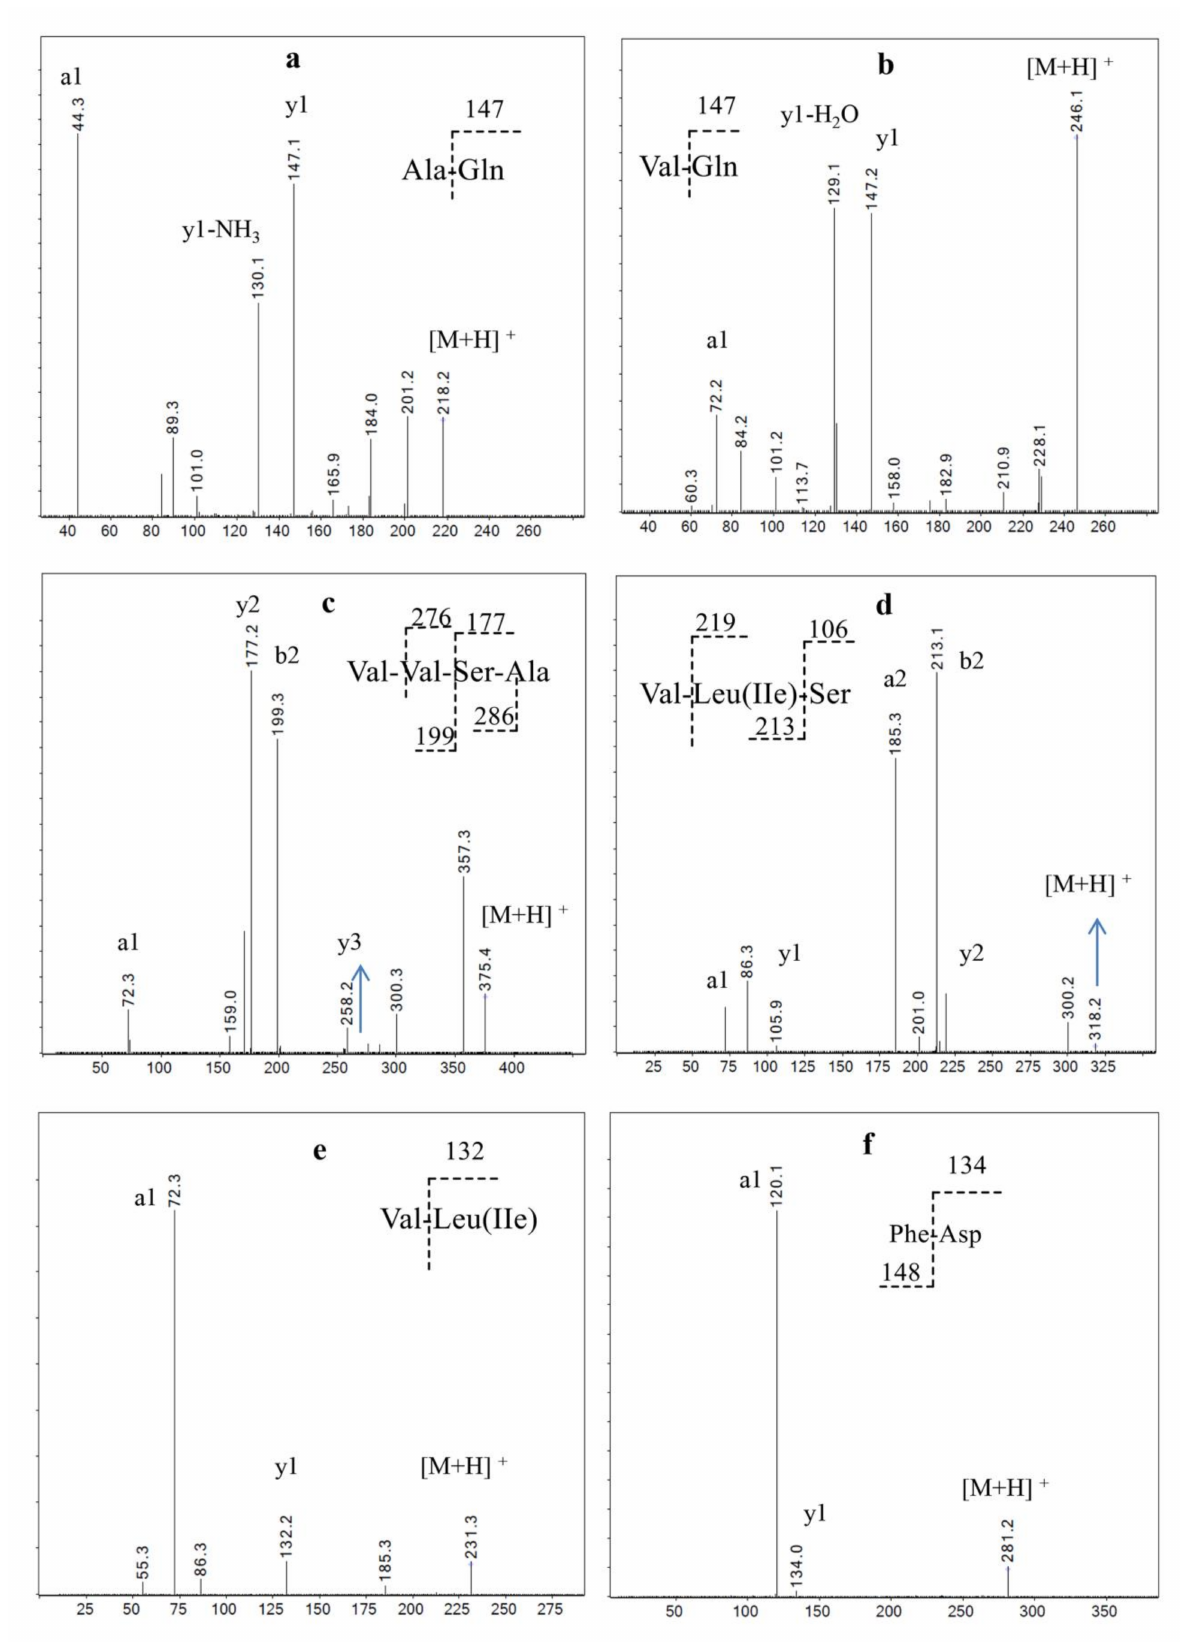
Figure 4. MS/MS spectra analysis of the main peptides Fr1and Fr2, ( a ) Ala-Gln, ( b ) Val-Gln, ( c ) Val-Val-Ser-Ala, ( d ) Val- Leu(Ile)-Ser, ( e ) Val-Leu(Ile), ( f )